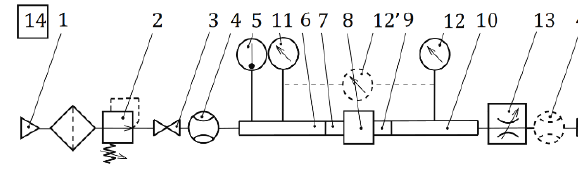
Fig. 7. Diagram of the stand for determining flow